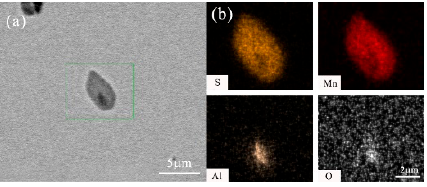
Figure 5. Typical MnS diagram with oxide as the nucleation core ( a ) SEM morphology of inclusions; ( b ) composition distribution of inclusions.